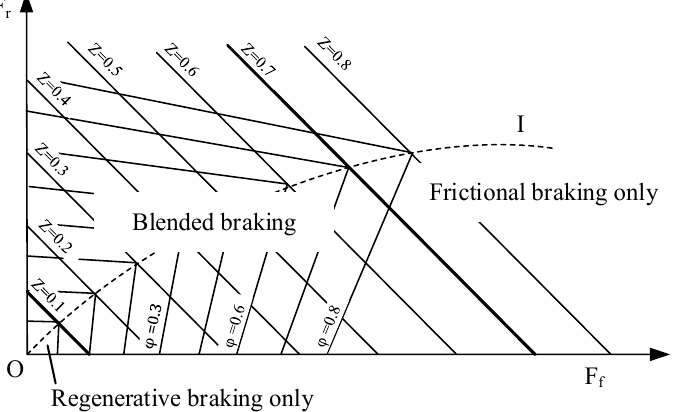
Figure 3. Braking modes. ( F f ) Braking force in the front axle; ( F r ) braking force in the rear axle; ( φ ) the attachment coefficient; ( I ) the ideal braking force distribution curve.